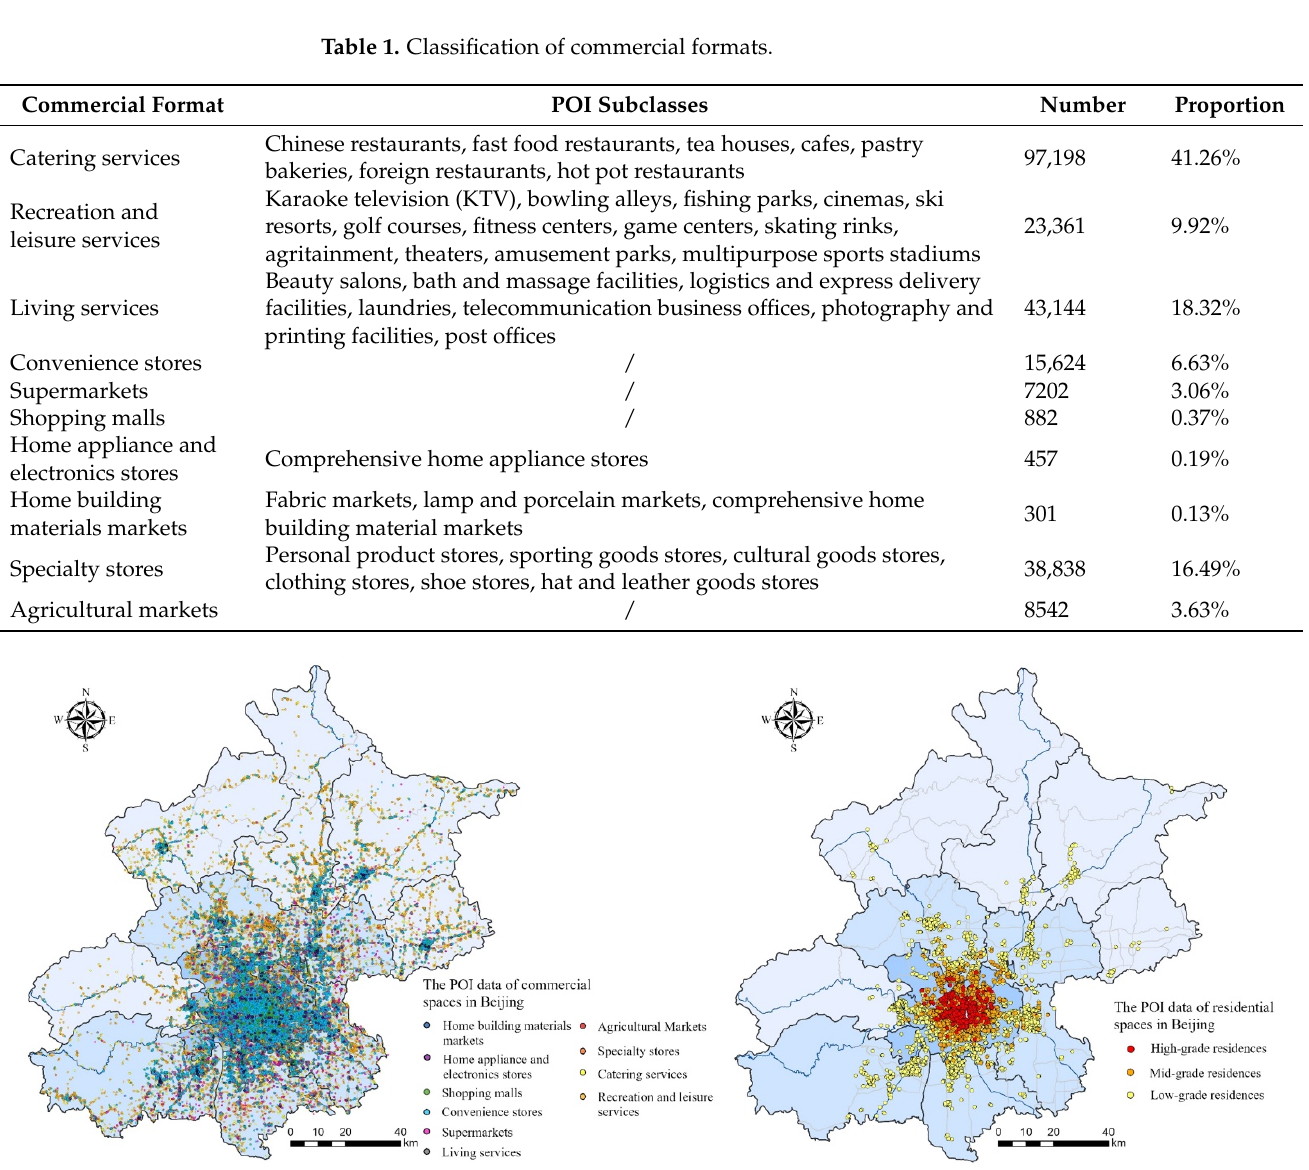
Figure 2. The POI data of commercial and residential spaces in Beijing. Table 1. Classification of commercial formats.